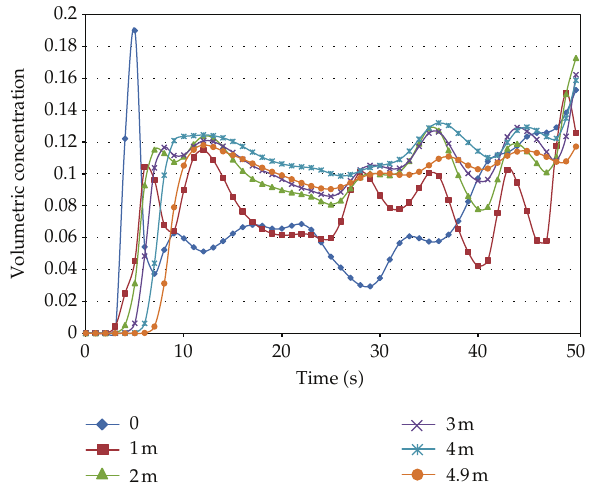
Figure 10: Hydrogen volumetric concentration versus time for Model 3 (cid:2) hydrogen inlet velocity of 0.67ms − 1 (cid:3) at 6 sensor positions, having slip in the x -direction, and C (cid:8) 0 at the tunnel